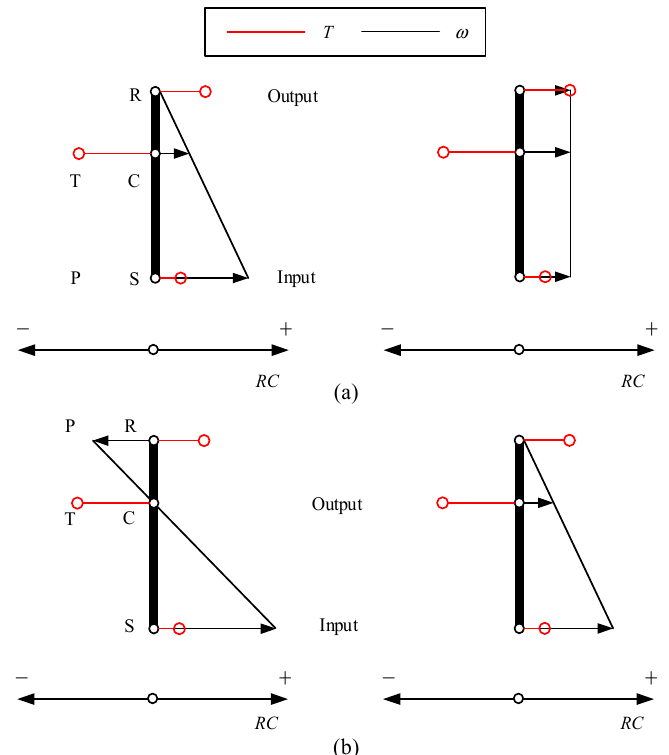
Figure 7. Lever diagram. ( a ) Discriminant method for the scheme in Figure 6a; ( b ) Discriminant method for the scheme in Figure 6b.